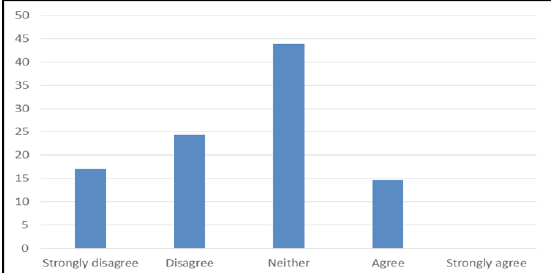
Figure 3. When in the classroom, I en- courage cooperative learning